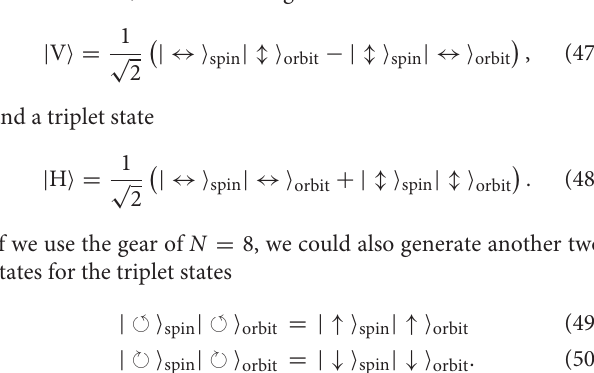
10. The input port 1 and 2 are used to inject photons to the waveguide, and the phase of the input 2 is = 1 µ m above the gear. (A) The amplitude ( = E x ) and (D) the phase ( φ y )of the horizontal electric field E y . The phase is not obviously rotating any more. A diagonal | |